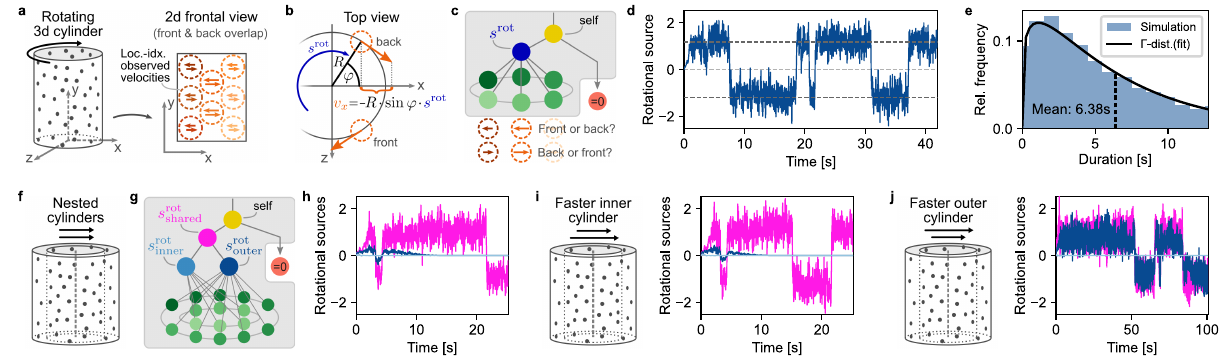
Fig. 6 | Object recognition and perceptual switching of nested structure-from- switches randomly between CW and CCW rotation with constant angular speed. motion (SfM) displays. a Cylindrical SfM stimulus. A random point cloud on the e Distribution of perceptual switches. The distribution of duration-of-percepts surface of a rotating, transparent cylinder (left) supports two possible percepts closely follows a Gamma distribution, as commonly reported in human psycho- when viewed from the front without depth information (right). Humans perceive physics. f Extension of the SfM display adding a smaller point cloud-cylinder, the structured motion of this 2D projection as a rotating 3D cylinder, albeit with nested within the original cylinder. g Motion tree for the extended experiment. bistable direction of the perceived rotation. b Top view illustration of how the Three rotational components are provided: shared rotation of both cylinders, generative model supports rotational motion. The rotational motion source, s rot t , rotation of the outer cylinder, and rotation of the inner cylinder. The correspon- describes angular velocity about the vertical axis ( s rot >0 for CCW rotation, by dence problem now demands assigning 4 observations where both cylinders de fi nition). In location-indexed experiments, observed velocities, v t , at a ( fi xed) overlap. h Perceived structure for identical angular speed of both cylinders. The location with angle φ and radius R are a linear function of the rotational motion model infers a single shared rotational component. i Fast inner cylinder. When source. In the frontal view of SfM experiments, only the x-component, increasing the angular speed of the inner cylinder by 50% (sketch on the left), the v y =0, are visible. c Motion tree v x = (cid:1) R sin ð φ Þ s rot inferred structure is unaffected (right): the cylinders are perceived as having the t , and the vertical y-component, and correspondence problem. The graph contains self-motion, rotational motion sameangularvelocity. j Fastoutercylinder.Incontrast,whenincreasingtheangular of the entire cylinder, and individual motion for every location. For any x-y coor- speed of the outer cylinder by 50% (left), the cylinders ’ speeds are perceived as dinate, there exist two overlapping observed velocities which are ambiguous separated (right). For visual clarity, the trees in panels c and g show only 5 and 3 regarding their depth position (front or back). We performed the assignment of receptive fi eldlocationsfortheouterandinnercylinder,respectively,whileforthe observationstotheirperceiveddepth(frontorback)suchthatthepredictionerror, simulations, we used 7 and 5 locations. Source data are provided as a Source ϵ t ,inEq.(2)isminimized. d 3Dperceptandperceptualbistability.Likehumans,the Data fi model identi fi es rotation as the single motion component. The value of s rot t